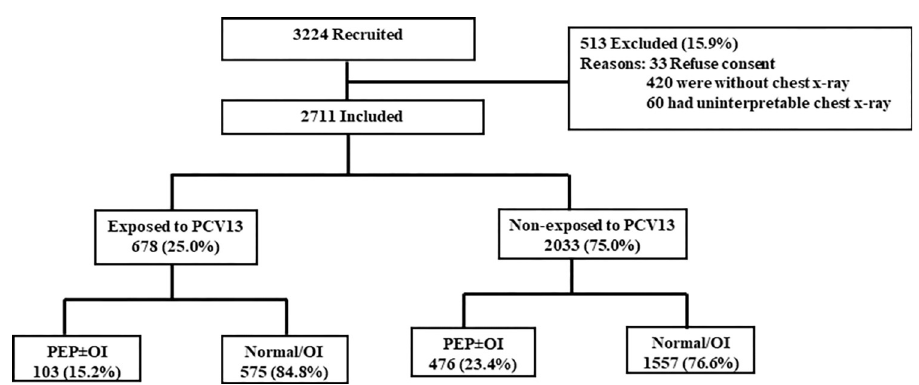
Fig 1. Flow diagram of hospitalized children (2–23 months) with community acquired pneumonia recruited from Darbhanga (1 st June 2017-30 th April 2021), Patna (1 st June 2018 to 30 th April 2021) and Lucknow (1 st June 2018 to 30 th April